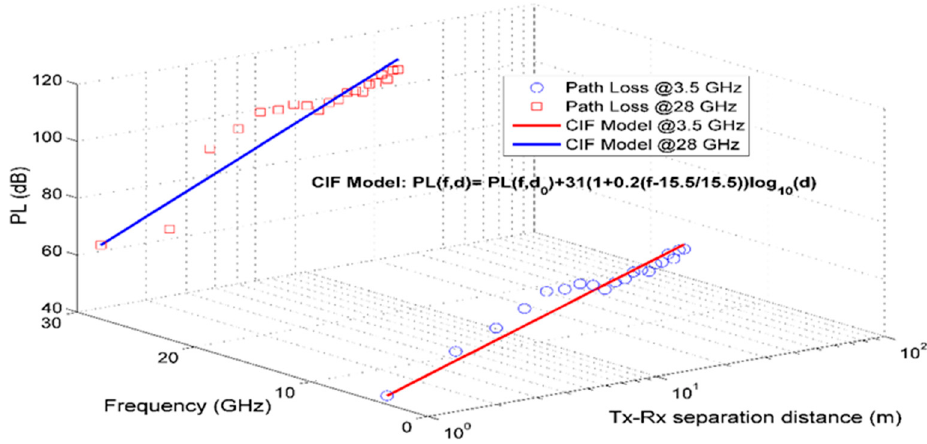
Figure 9. CIF path loss model versus Tx-Rx separation distance for NLOS scenario.